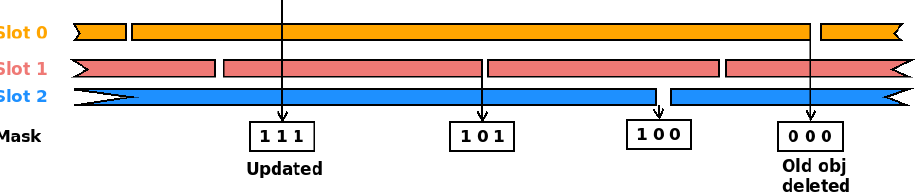
Figure 1. Managing object lifetime with RCU. After an object is updated, the old one can be deleted after each concurrent slot completes processing for an